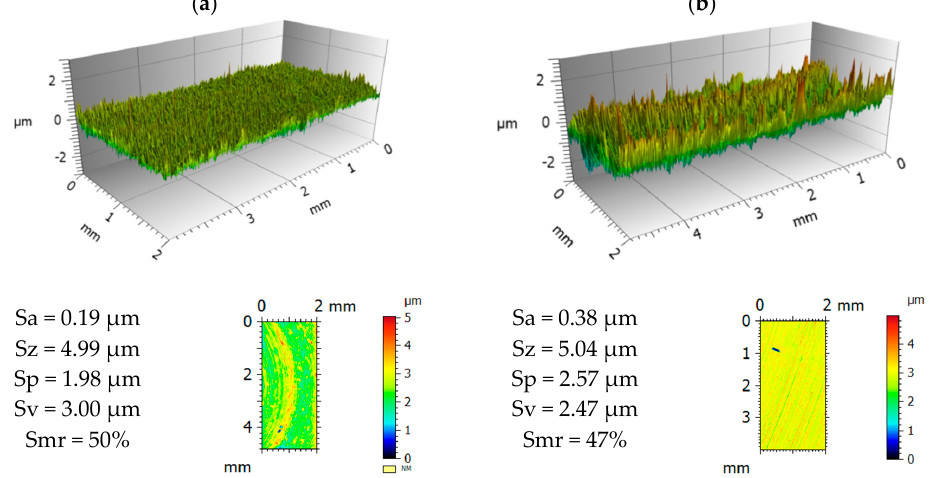
Figure 9. 3D view and statistical characteristics of samples surface of Vancron 40 steel after: ( a ) G-SN and ( b ) T-B130-SN.